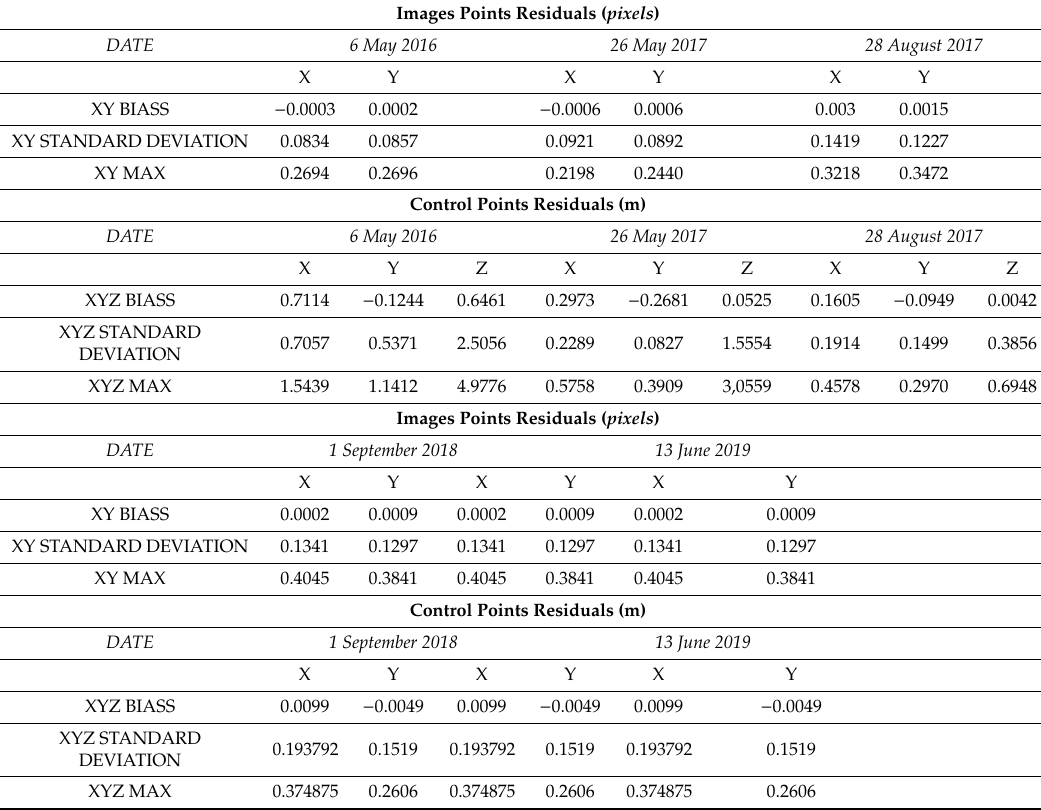
Table 5. Results of the PL É IADES images